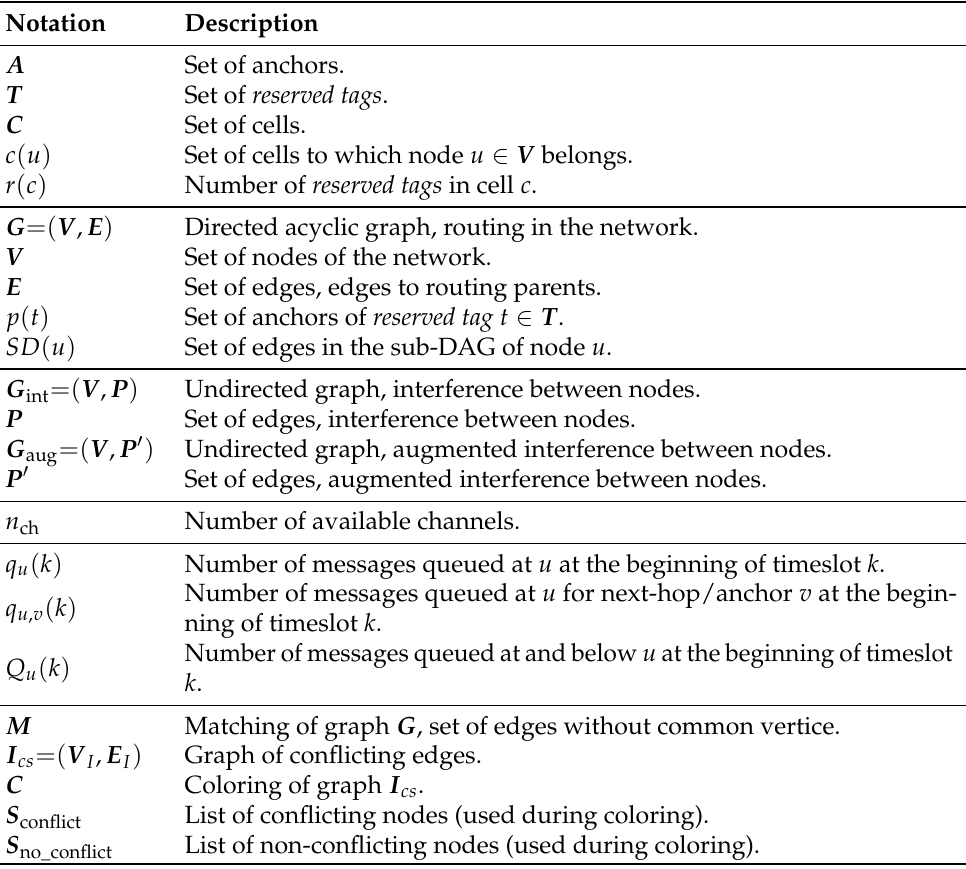
Table 3. Summary of mathematical